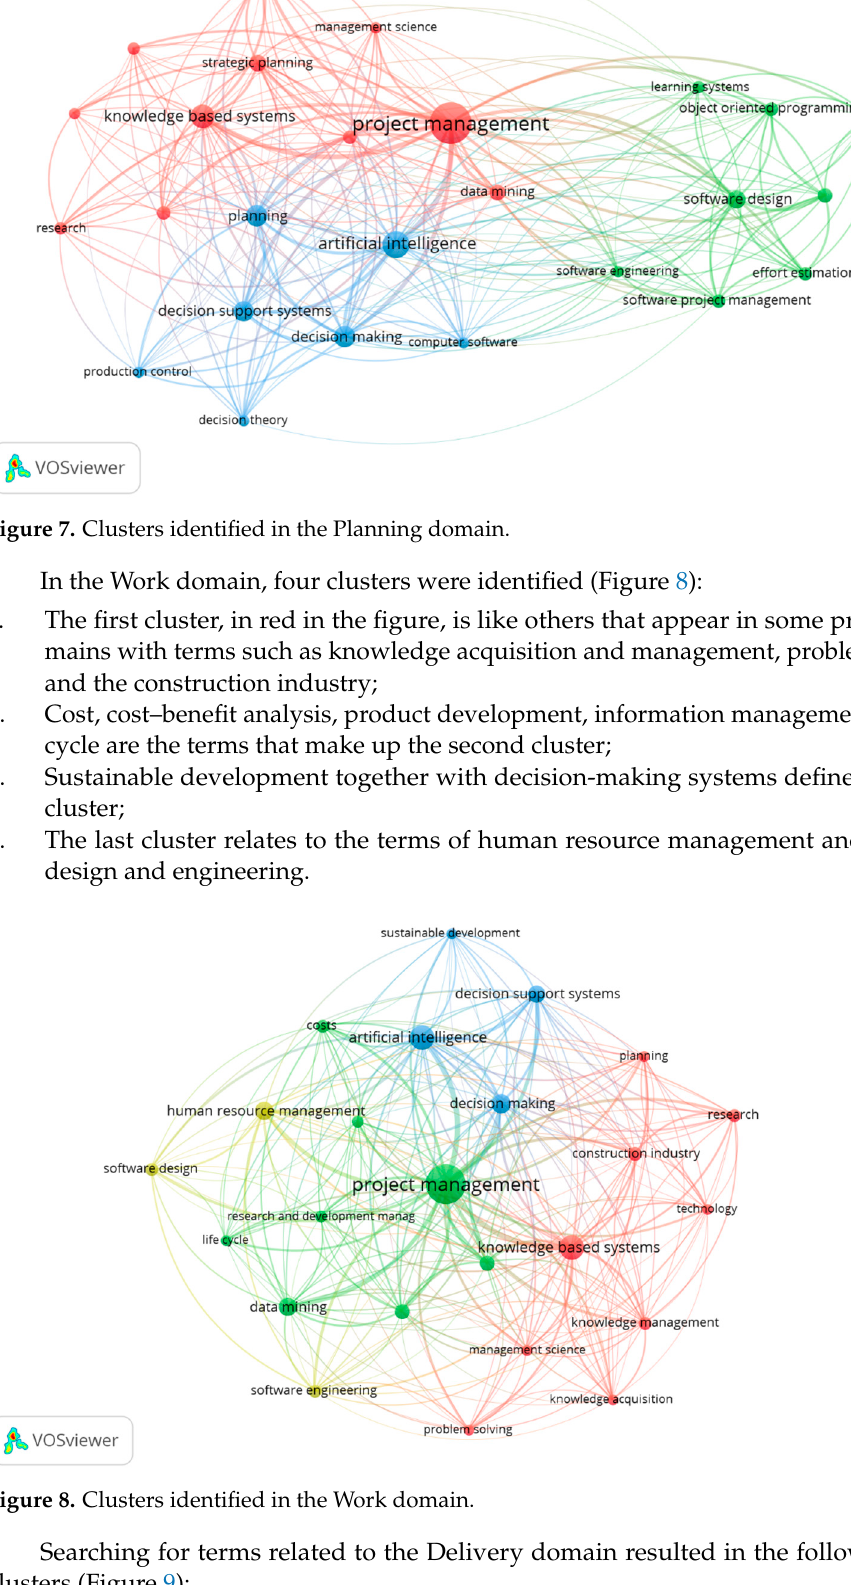
Figure 9. Clusters identified in the Delivery domain. Analysis of the bibliographic results obtained related to the Measurement domain search gave rise to the following five clusters: 1.